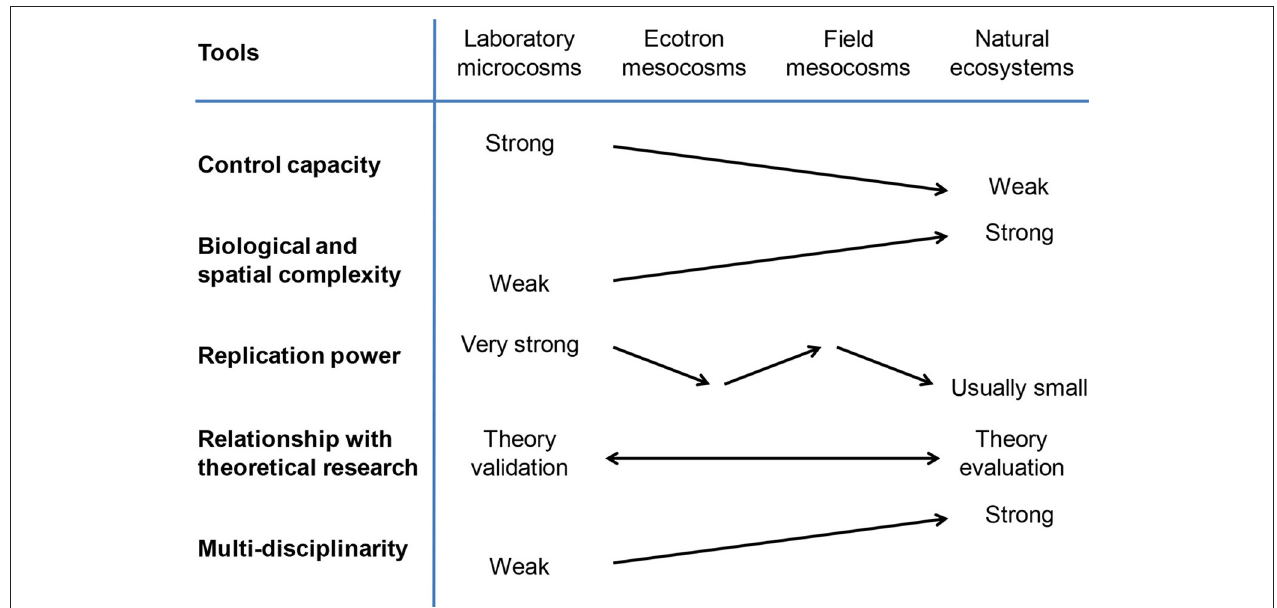
FIGURE 1 | The design of an experimental set-up typically involves several trade-offs. Here, experimental set-ups were arranged by size from small laboratory microcosms, highly controlled laboratory mesocosms inside Ecotrons, field mesoscosms and natural ecosystems. Control capacity describes the level of environmental control that the experimental set-up can offer and it typically decreases from enclosed, laboratory systems to natural ecosystems ( Petersen et al., 1999). Complexity defines the number of species, trophic levels or ecosystem types, as well as the spatial complexity in the environment, and it typically increases from laboratory to natural systems. Replication power is related to the maximum number of experimental units and, given budgetary and technical constraints, it decreases with the spatial scale and technological complexity of the experimental set-up. Internal validation defines the extent to which the experimental set-up can be used to test for a given theory and it trade-offs with theory evaluation as spatial scale increases (De Boeck et al., 2015). Multidisciplinarity is the extent to which several disciplines can work together in the experimental set-up, and it increases on average with spatial scale ( Stewart et al.,